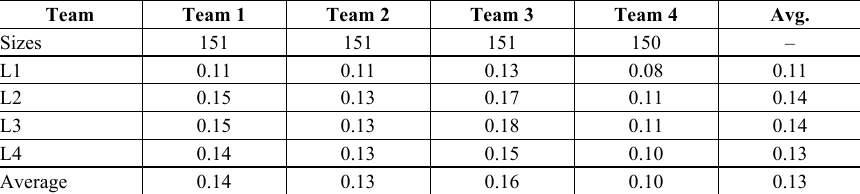
Table 3. Team participation in quizzes over the time-sorted lectures for